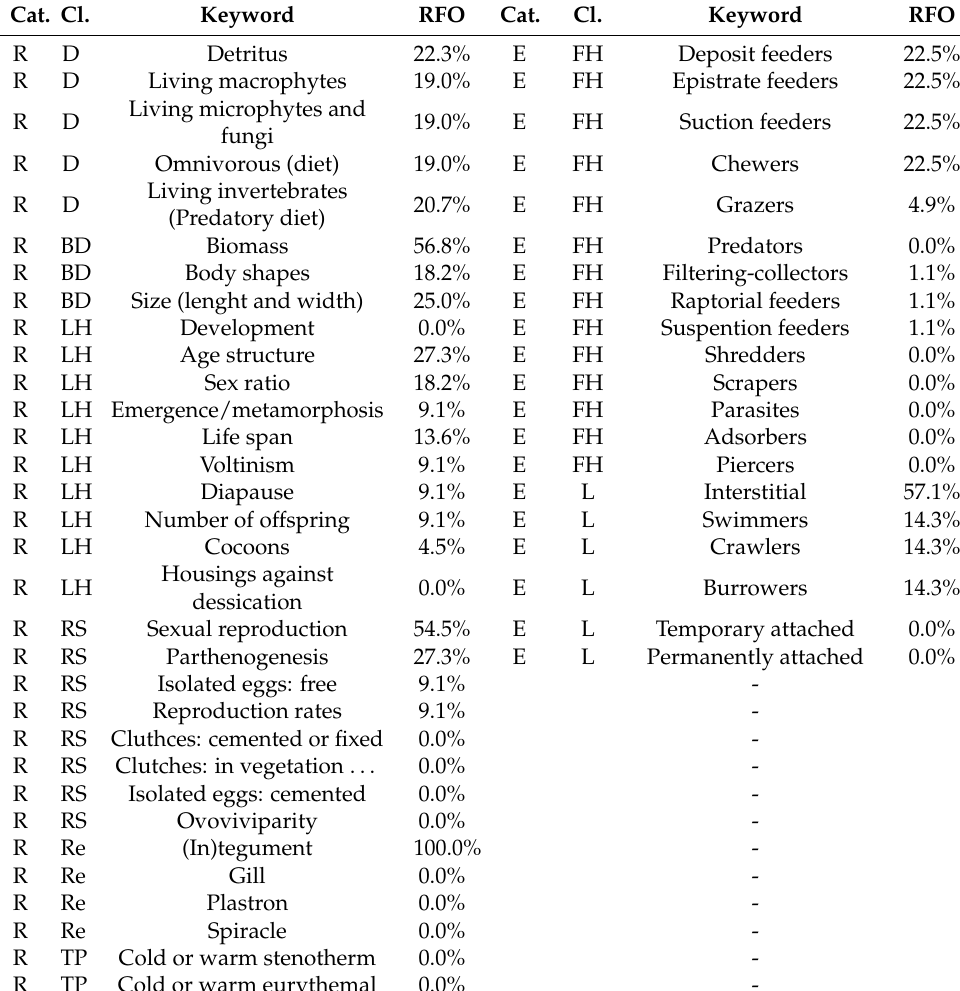
Table 1. Relative frequency of occurrence (RFO) of the trait keywords in the 62 papers concerning the meiofauna of the littoral zone of lakes. Cat: category; Cl.: class; R: response trait; E: effect trait; D: diet; BD: body size, shape and mass; LH: life history; RS: reproductive strategy; Re: respiration; TP: thermal preference; FH: feeding habits; L: locomotion and substrate relation. Cat. Cl. Cat.